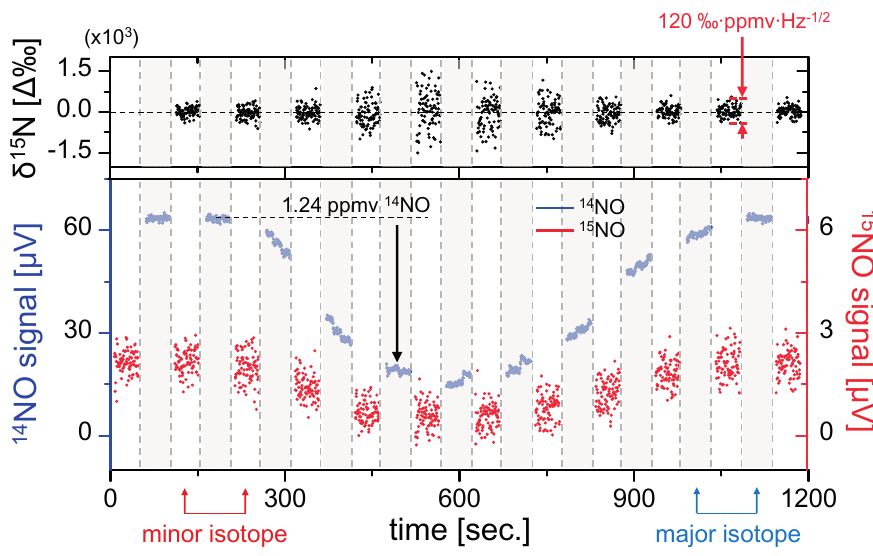
Figure 5. Quasi-simultaneous isotope measurement of 1.24 ppmv 14 NO in N 2 mixture diluted using pure nitrogen. Line-switching occurs every 50 s, and polynomial interpolation of 14 NO is used to calculate the isotopic ratio (top graph). Gray regions denote 14 NO measurements and white regions denote 15 NO. Permil ratiometric values are calculated according to Equation (12), demonstrating fractionation-free system performance.